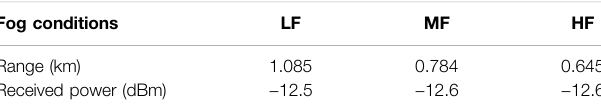
Table 9 summarizes the maximum propagation ranges with corresponding received power for the proposed system under different fog conditions with log (BER) < -2.5.